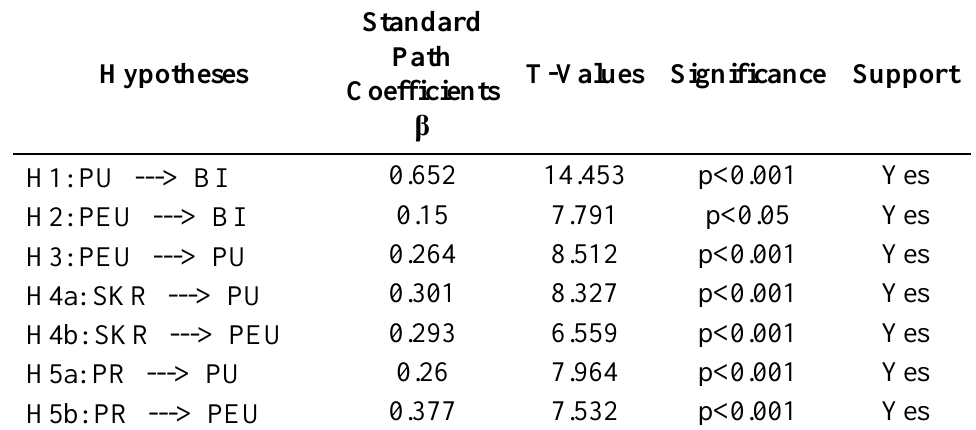
Results of Hypotheses